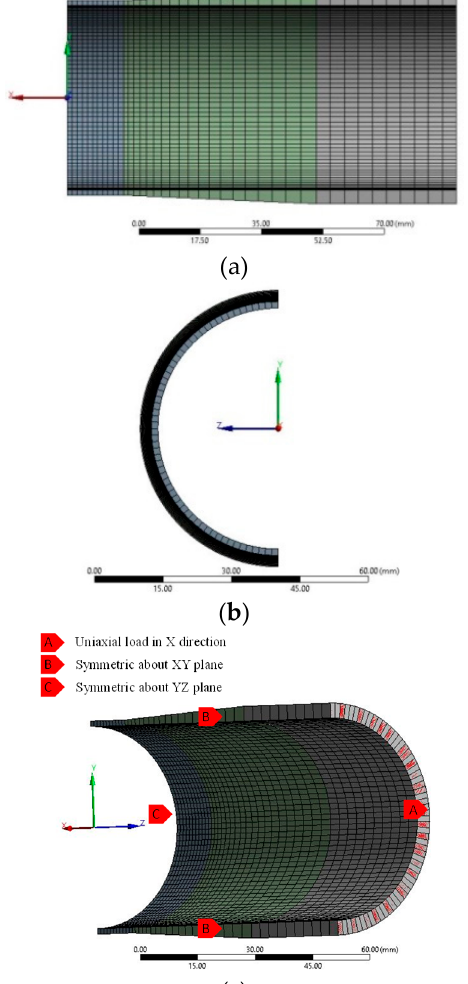
Figure 17. Finite element model of uniaxial specimen: ( a ) Inside surface symmetric about X-Y plane, ( b ) through thickness symmetric about Y-Z plane, ( c ) boundary condition.